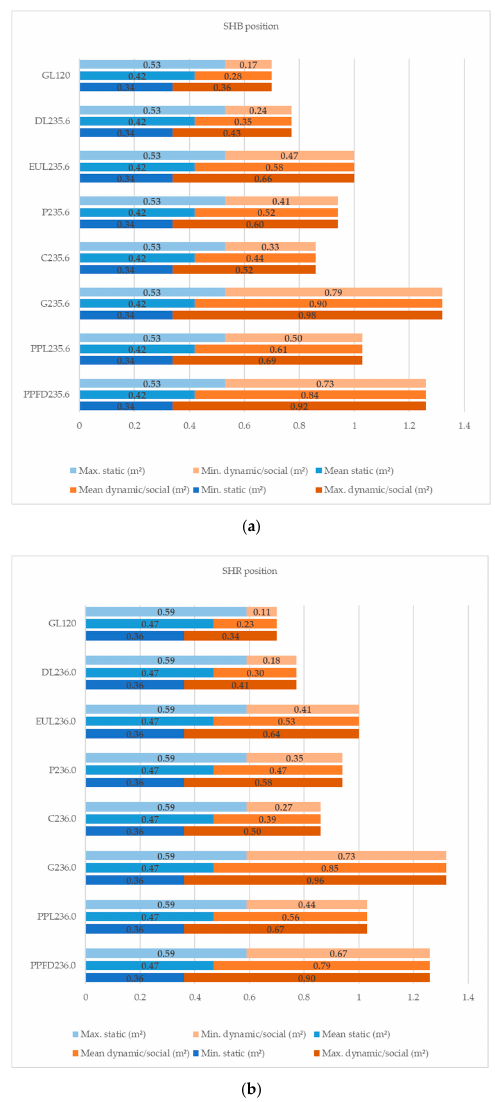
Figure 2. Static and social/dynamic space for sows in standing position ( a ) SHB and ( b ) SHR with a different minimum space available (with SHB = Standing head bowed, SHR = Standing head half or fully raised, Min = minimal value, Max = maximal value, static = static space, social/dynamic = social and dynamic space, abbreviations on the y -axis: see Table